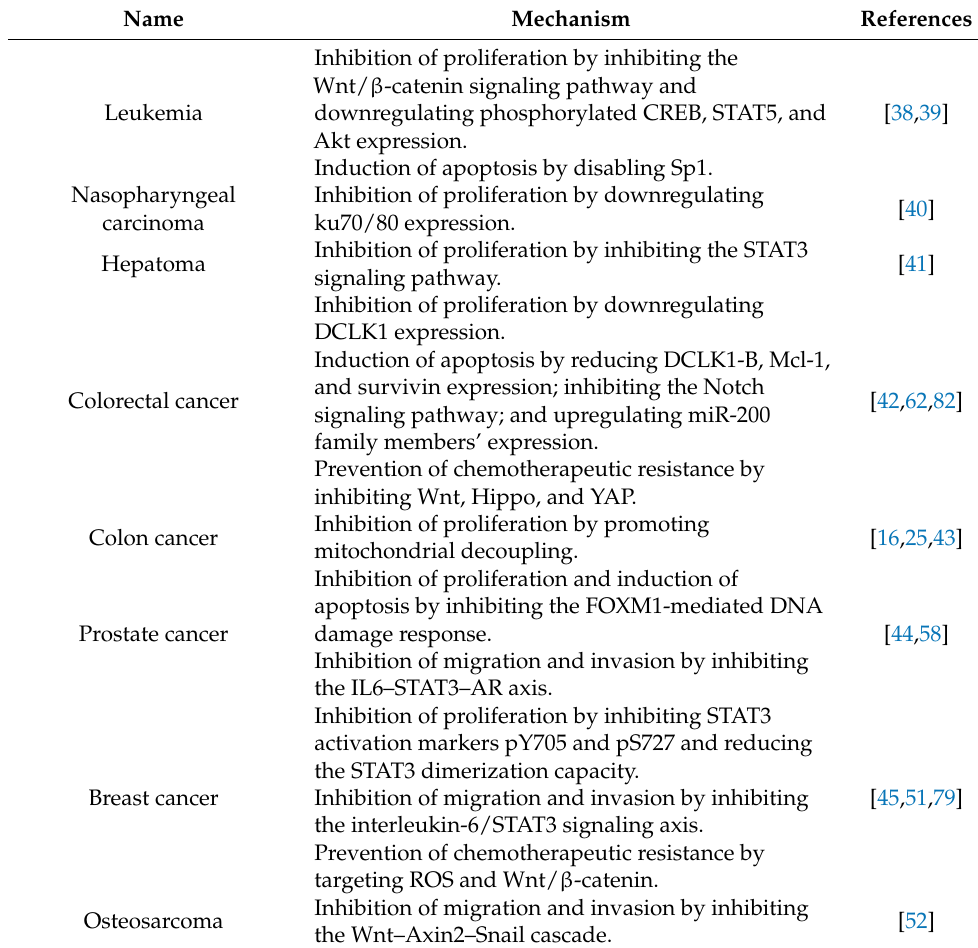
Table 1. The pharmacological activity and mechanism of NIC and its derivates in